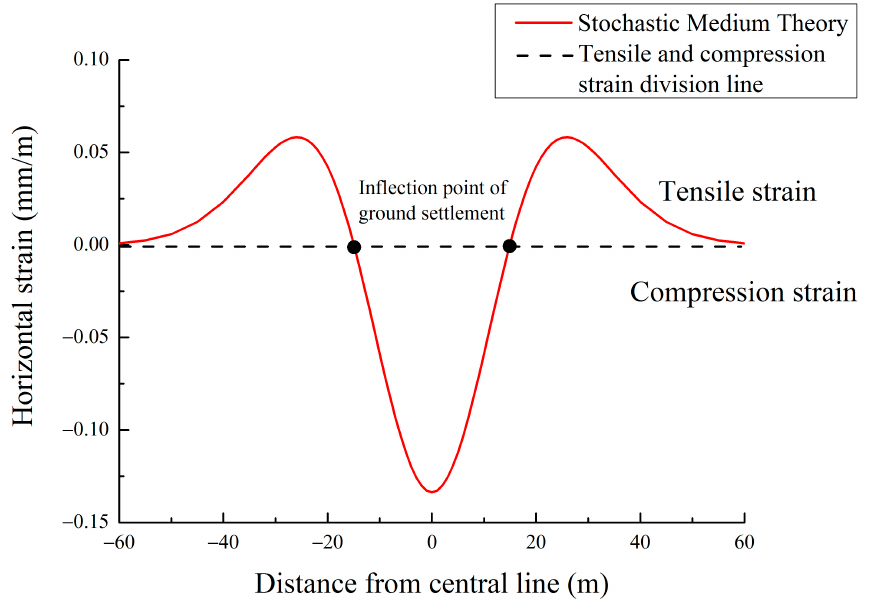
Figure 11. The horizontal displacement and the inflection point of ground settlement.